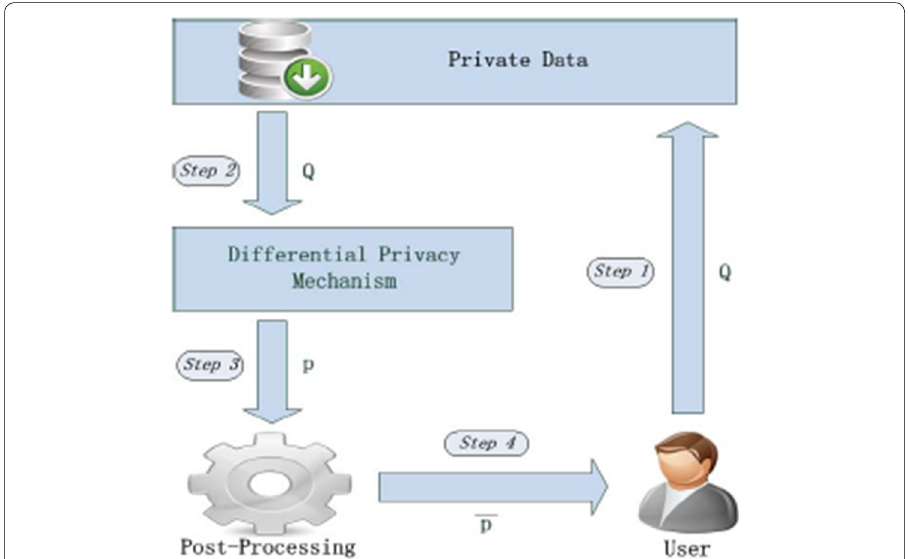
Fig. 6 Efficient e-health data release system model